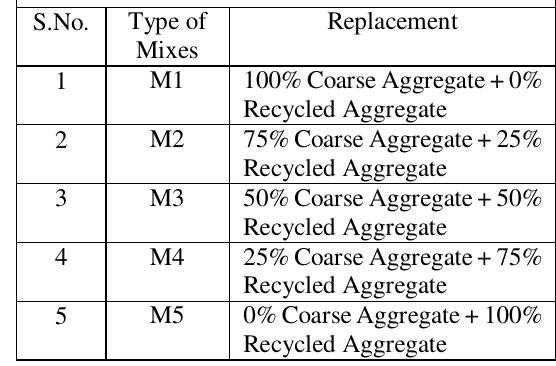
Table 1: Replacement Detail of Coarse Aggregate with